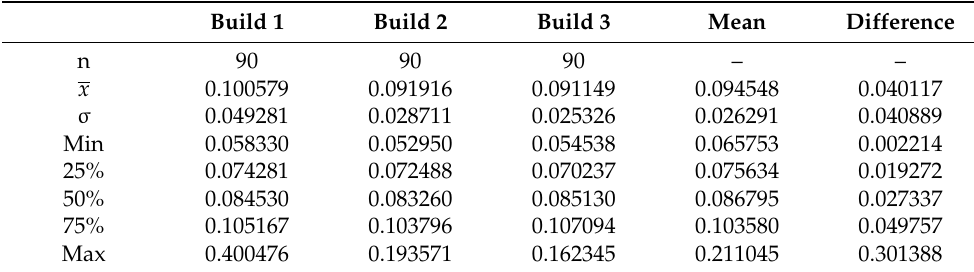
Figure 21. Comparison of measured error between builds considering vertical planes. ( a ) A boxplot visualizing the measured flatness error; ( b ) kernel density estimation of the measured values. Table 9. Statistical description of measured flatness error of planes 2 and 5 from HX2 and the difference between the three builds.